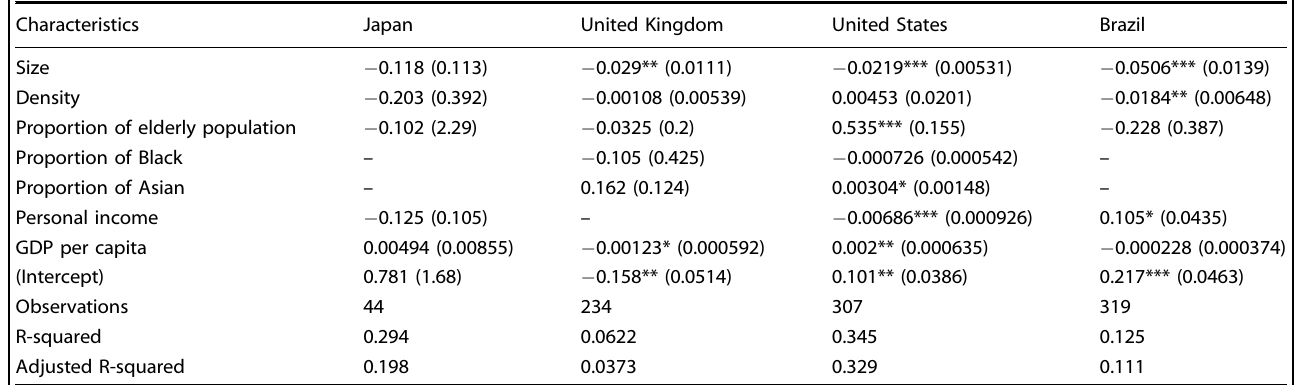
Table 1. Impact of settlement characteristics on the intrinsic speed of virus spread.